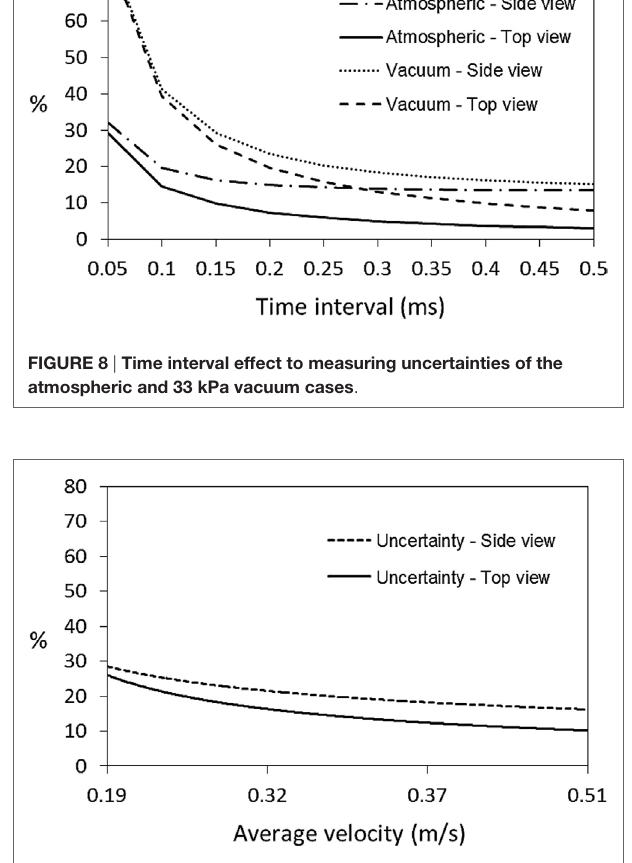
FigUre 9 | Mean flow speed effect to measuring uncertainties of the atmospheric and the vacuum cases .